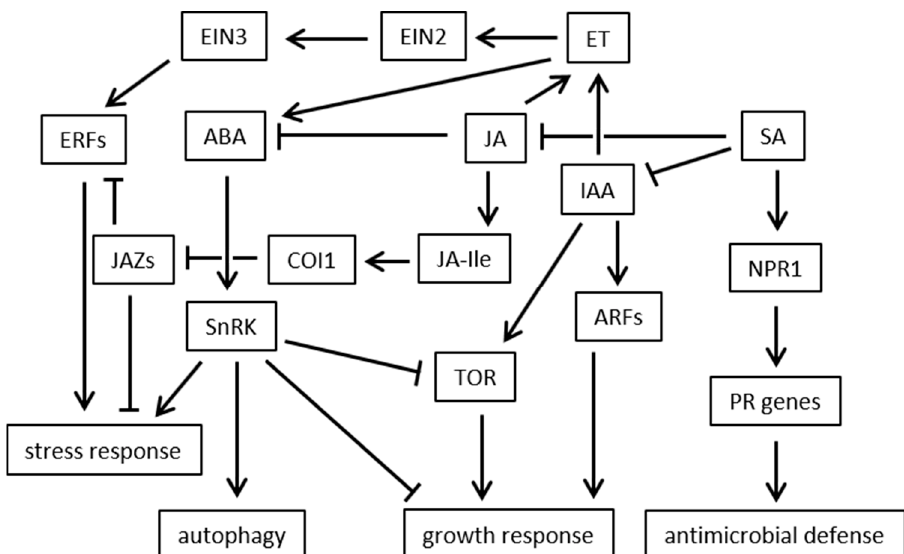
Figure 7. Simplified model of the contribution of different plant hormones to stress response; SA reduces the formation of IAA and induces the expression of non ‐ expressor of pathogenesis related gene 1 (NPR1). Localization of the NPR monomer in the nucleus activates TGA transcription factors (TFs) which can bind pathogenesis related (PR) gene promoters and activate transcription of defense genes. JA is induced upon biotic and abiotic stresses. It is converted to the biologically active form JA ‐ Ile which is perceived by its receptor COI1. COI1 triggers the degradation of JAZ repressors resulting in the release of downstream transcription factors and further induction of JA ‐ responsive genes. JA induces ethylene formation which activates ethylene insensitive 2 (EIN2), a transmembrane protein, which further induces the transcription factor EIN3 leading to expression of ethylene response factors (ERFs) triggering the stress response. ABA induces stress response and autophagy via SNF1 ‐ related protein kinase (SnRK) which on the other side inhibits the growth response and the target of rapamycin (TOR) but promotes stress response and autophagy. Auxin leads to the activation of auxin response factors (ARFs) as well as TOR which both trigger growth response.